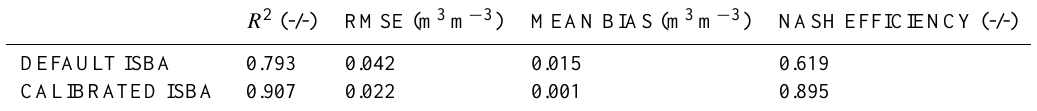
Table 5. Statistics obtained by comparing the in situ measurements from Melbex 1 campaign with the default/calibrated simulated soil moisture using ISBA. R 2 (-/-) RMSE (m 3 m − 3 )